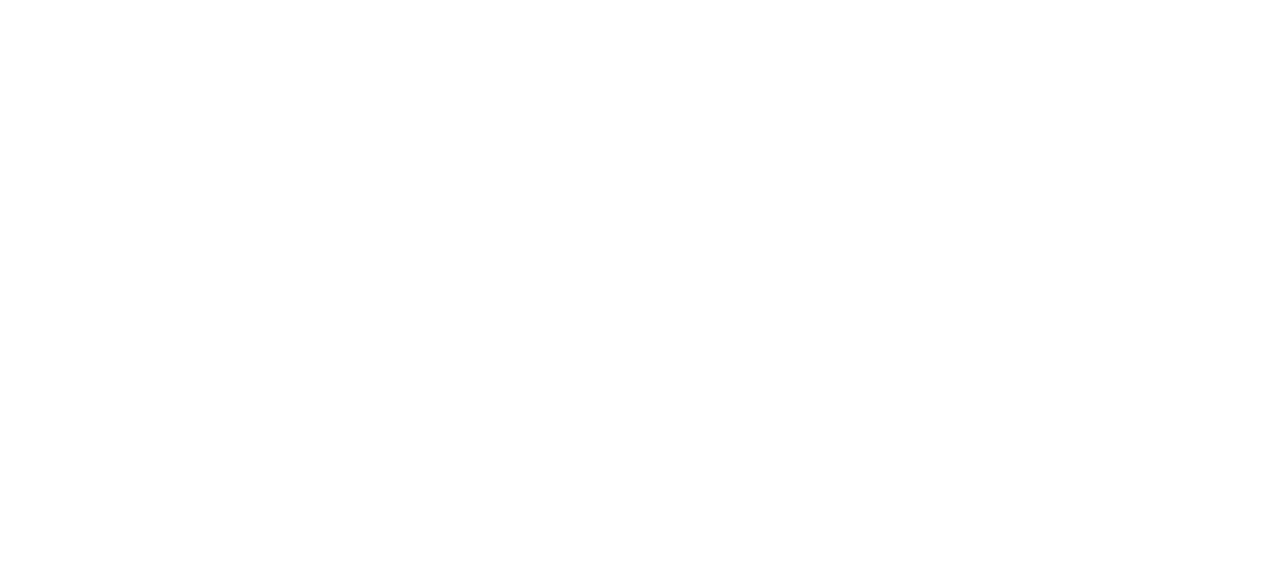
605.8 of sample KTS8; (H) MS 2 449.8 of sample KTS9. Only in the MS2 spectra of (G,H) can one not recognize the dissociation spectrum of a GILT signal